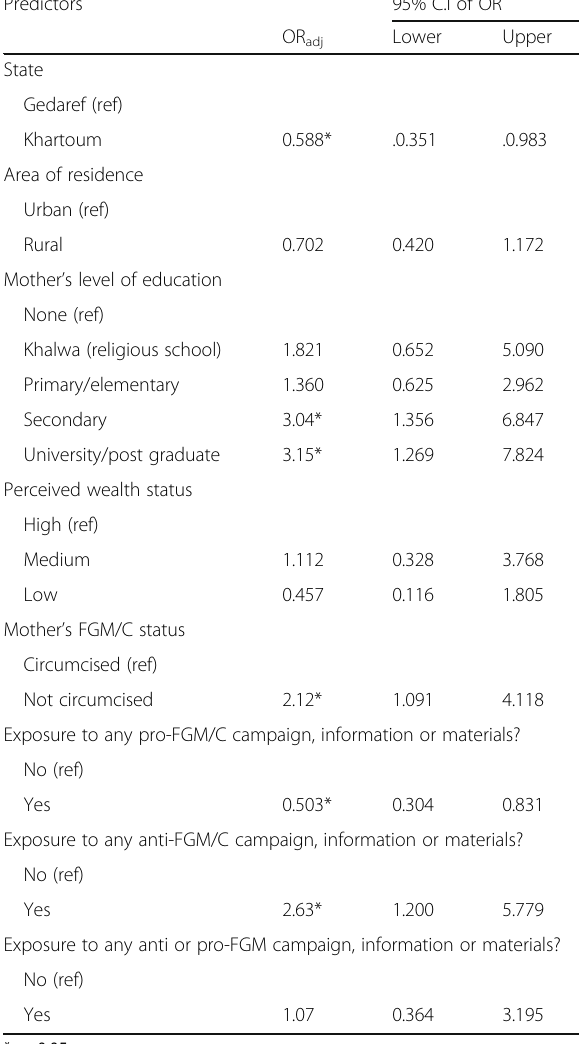
Table 2 Predictors of the decision not to cut youngest daughter